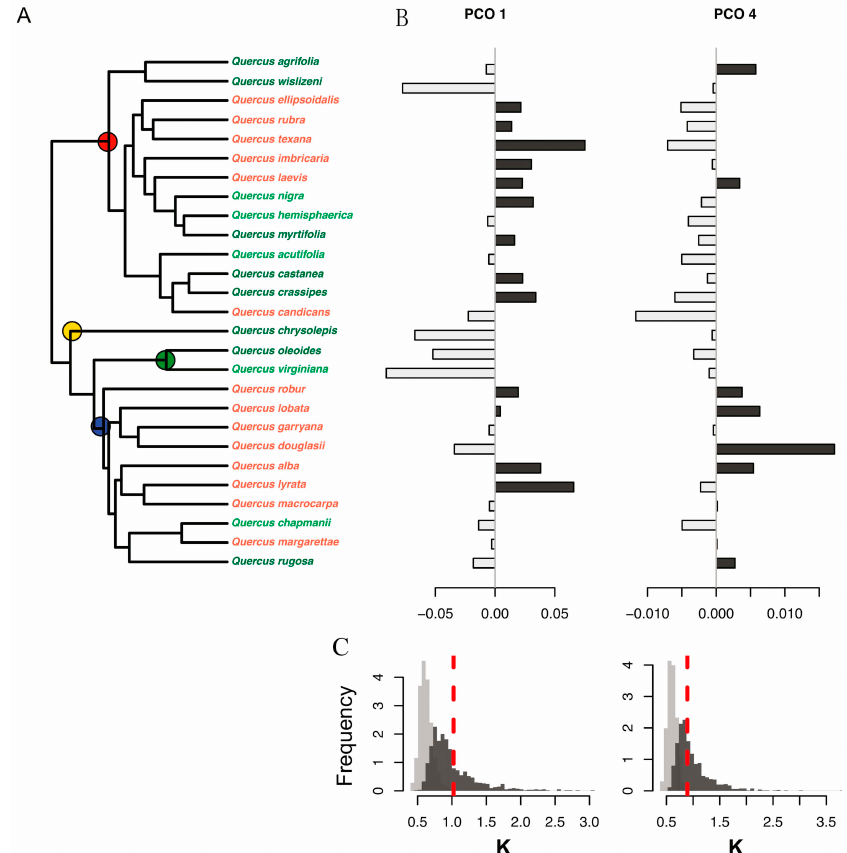
Figure 4. ( A ) Molecular phylogeny of 28 oak species showing principal coordinate scores to the right of each species. Leaf habit is indicated by letter codes and coloring of species names, as follows: D = deciduous (red), E = evergreen (dark green), and BD = brevi-deciduous or semi-evergreen (light green). The four recognized higher level clades are indicated with colored circles as follows: red, red oaks (section Lobatae ); blue, white oaks (section Quercus ); green, live oaks ( Virentes ); and yellow, golden cup oaks ( Protobalanus ). Species values for the first and fourth principal coordinate (PCO) axes are shown to the right: ( B ) PCO1 and PCO4. Positive PCO axis values are shown in dark gray, negative in light gray. Distributions of observed values of Blomberg’s K statistic (red dashed lines) are shown relative to a Brownian motion (BM) model of evolution (dark gray bars) and relative to a white noise model in which phylogenetic relationships are completely randomized (light gray bars) for ( C ) PCO1 ( left ) and PCO4 ( right ) species scores. Observed K values for the PCO1 and PCO4 scores are consistent with a Brownian motion model of evolution and show higher phylogenetic conservatism than expected based on random relationships.